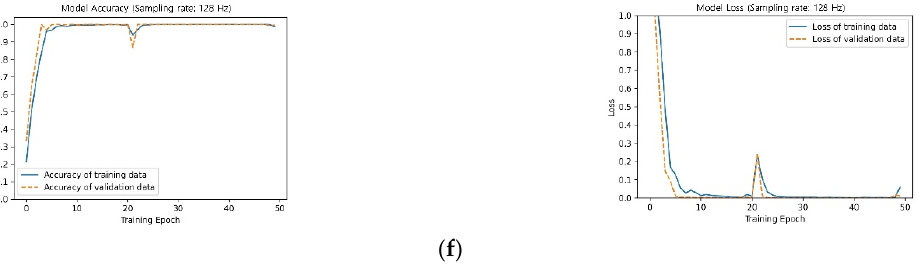
Figure 6. Accuracy and loss of the fault classification by sampling rate: ( a ) 25,600 Hz; ( b ) 12,800 Hz; ( c ) 2560 Hz; ( d ) 1280 Hz; ( e ) 256 Hz; and ( f ) 128 Hz.